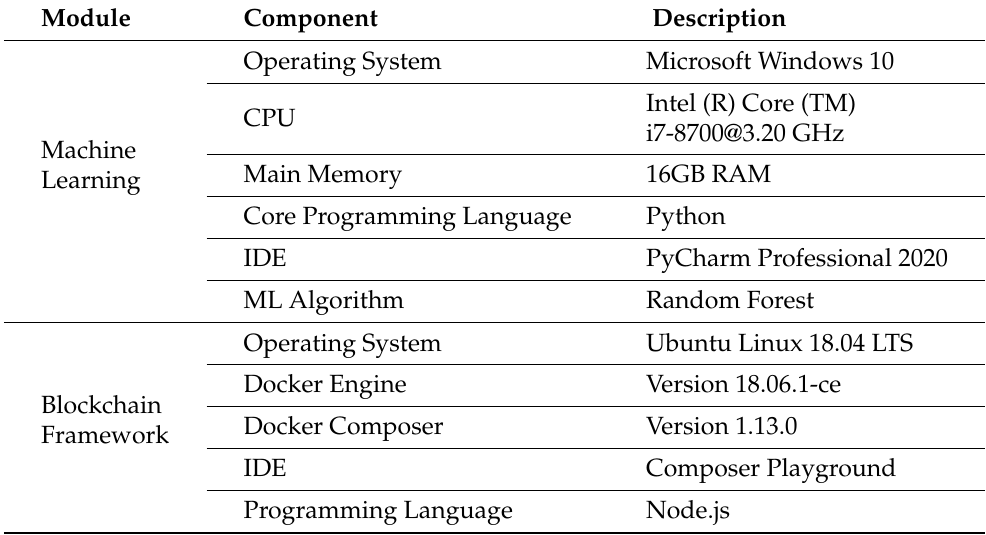
Table 3. Development environment.